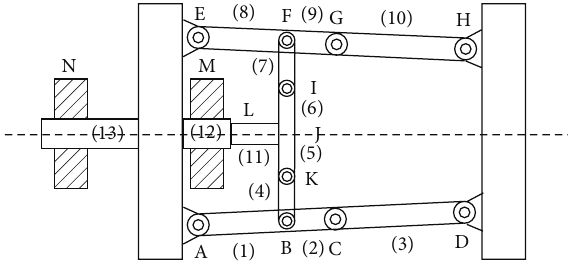
Figure 2: The beam element and the nodal displacements.